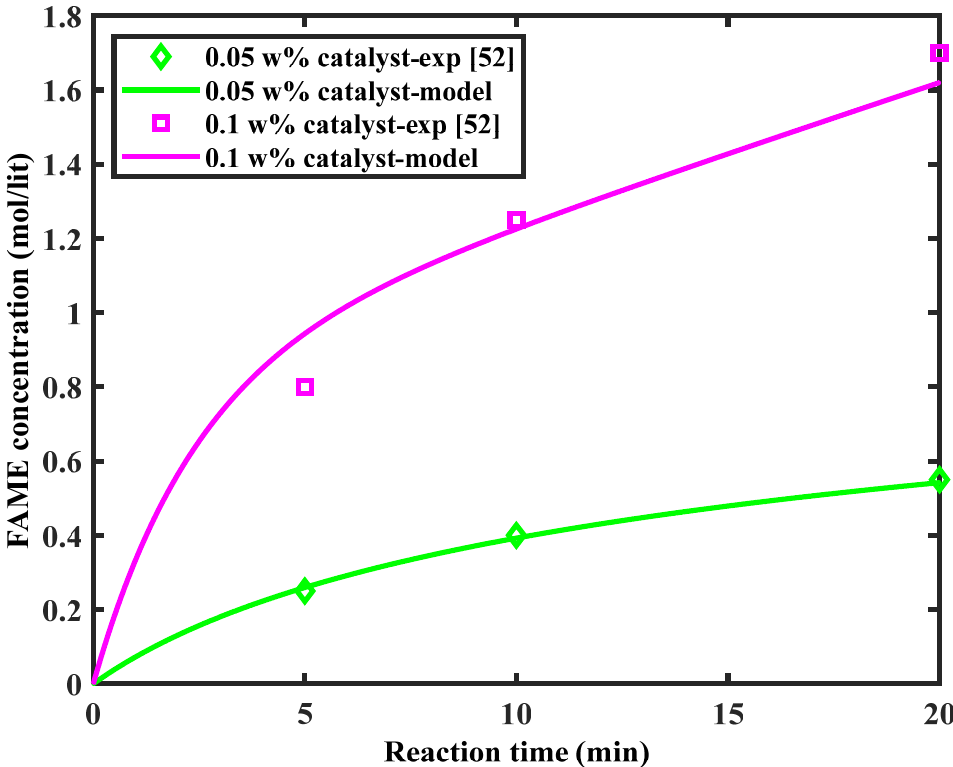
Figure 10. The comparison of experimental and calculated FAME concentration variation in the membrane reactor.